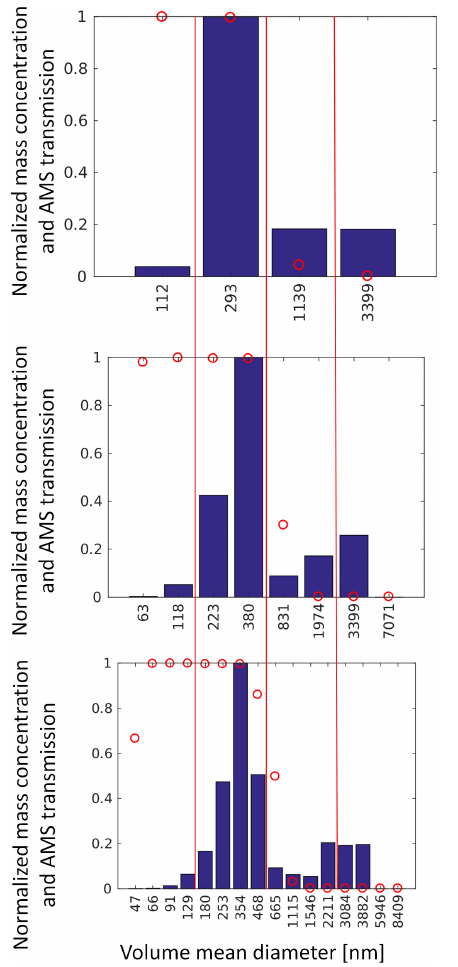
Figure 8. Resulting average size distributions (blue bars) when ag- gregating observed data (02:00–05:00UTC) to 4, 8, and 16 size bins. Sizes distributions show the average mass concentration in each bin normalized by the maximum value within each distribu- tion. Red lines separate bins aggregated when going from a finer to coarser bin representation. Size bins boundaries are defined in Ta- ble 3. Red circles indicate the average AMS transmission efficiency (dimensionless) for each size bin.